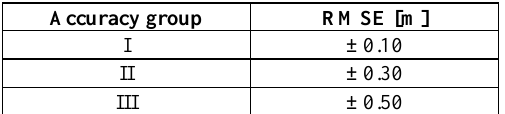
Table 2. The accuracy groups of the terrain details for the basic map of Poland